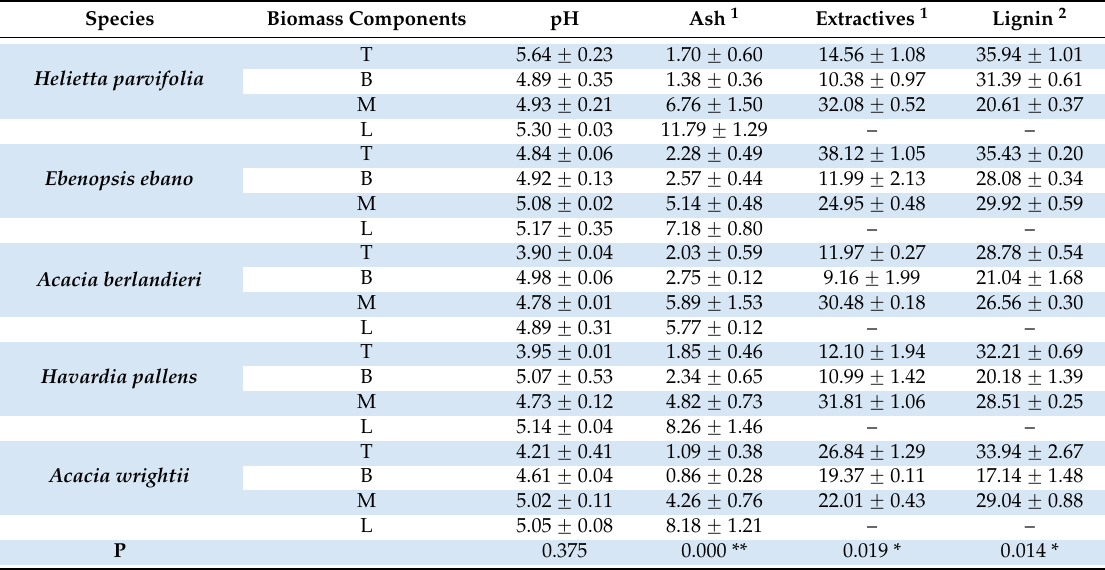
Table 2. Chemical constituents and standard deviations in different biomass components of five planted timber species of the semi-arid land of